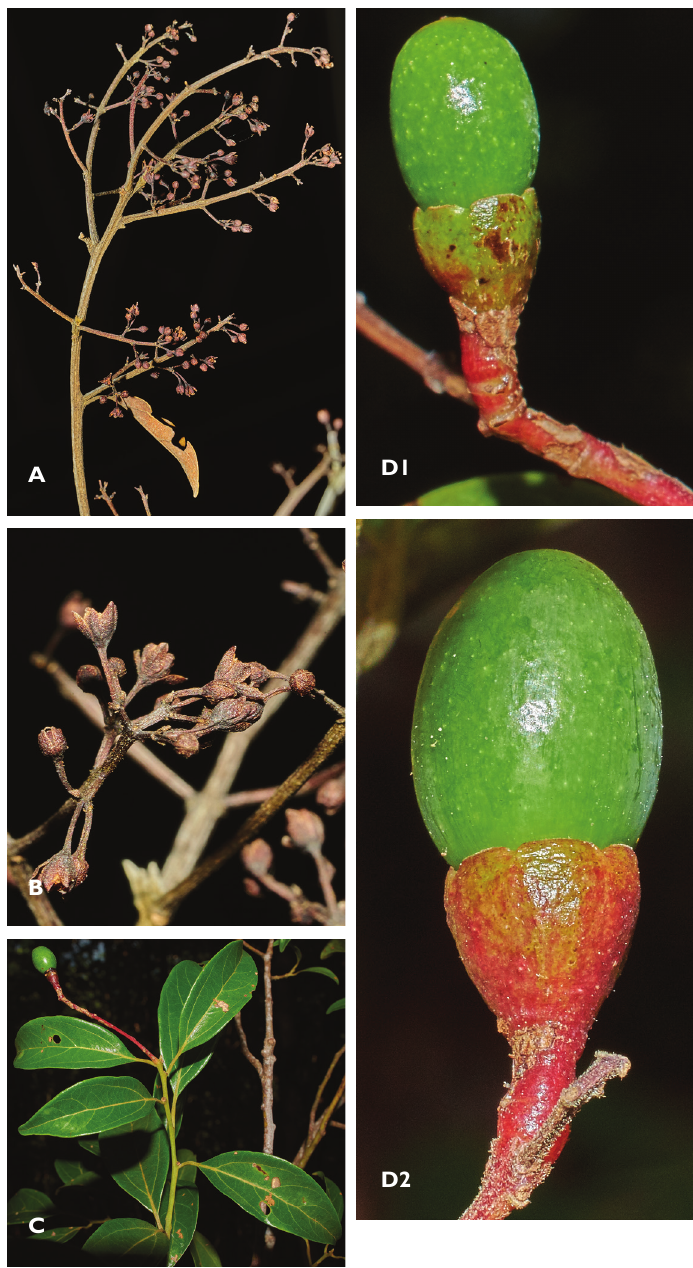
Figure 4. Diagnostic and other fertile characters of Cinnamomum bladenense A Axillary inflorescences on dry branch with all but one leaf removed to show variation in size and degree of branching B Apical por- tion of inflorescence showing flowers in bud and anthesis C Leafy branch with infructescence D Immature fruits with cupules showing partially turbinate pedicels, remnants of tepals at summit of the cupule, cupules turning red. Photos from Brewer & Stott 7529 by SW Brewer 2 February